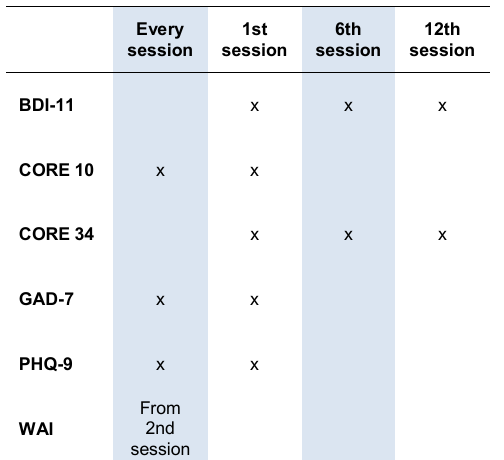
Table 1 sets out the various measures used and at which sessions. Table 1: Measures used per